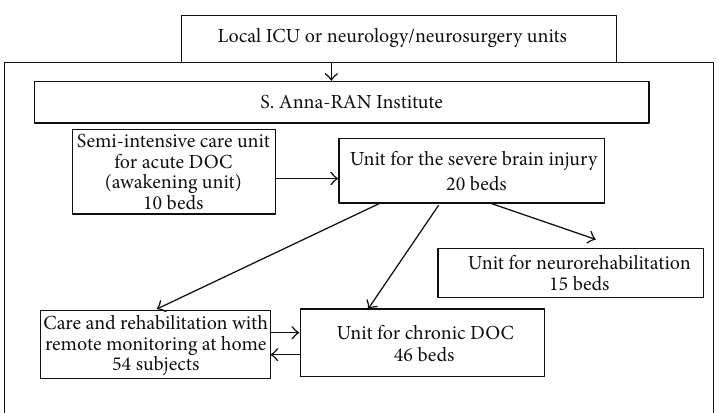
Figure 1: The S. Anna model for the care and neurorehabilitation of brain-injured subjects with DOC.